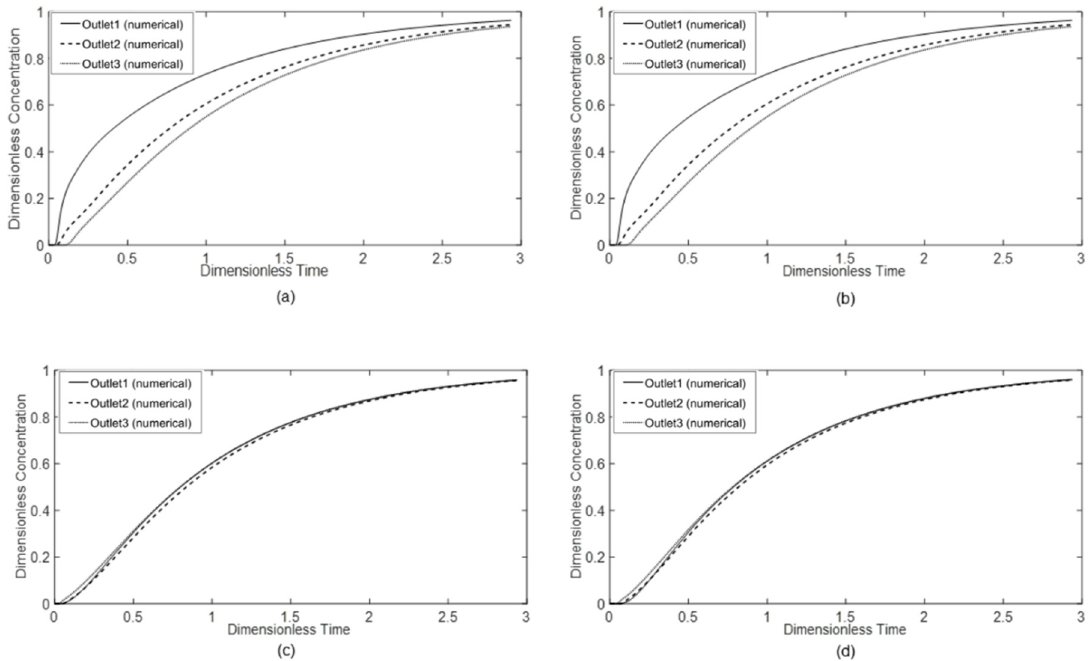
Figure 11. F ‐ curve of the numeric model. ( a ) Case 1—bare; ( b ) Case 2—TI; ( c ) Case 3—UB; ( d ) Case 4—UB + TI.